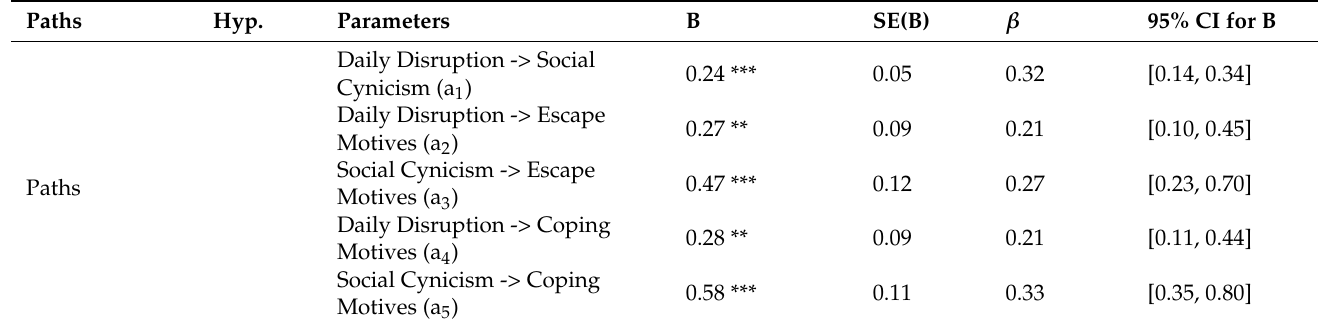
Table 7. Results from Hypotheses Testing of the Serial Mediation